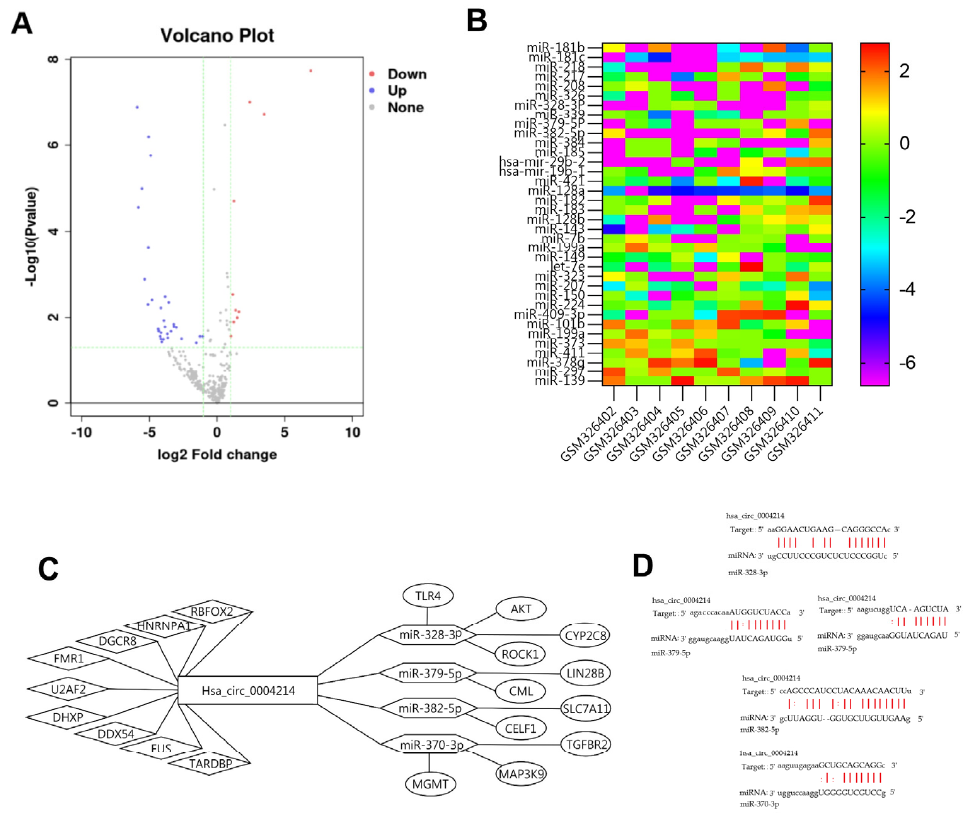
Figure 5. Construction of regulatory network associated with hsa_circ_0004214. (A) The vol- cano plot showing the expression profile of miRNAs in glioma tissue samples. ( B ) The heat map showing the top 20 down-regulated miRNAs and 10 up-regulated in glioma tissue samples compared with non-glioma brain tissue samples analyzed by RNA sequencing. ( C ) Construc- tion of a RBP/circRNA/miRNA/mRNA ceRNA Interaction network. The network consists of hsa_circ_0004214, 4 miRNAs, 12 RBPs, and 11 mRNAs. ( D ) From ENCORI, we predicted binding sites of miR-28-3p, miR-379-5p, miR-382-5p, and miR-370-3p with